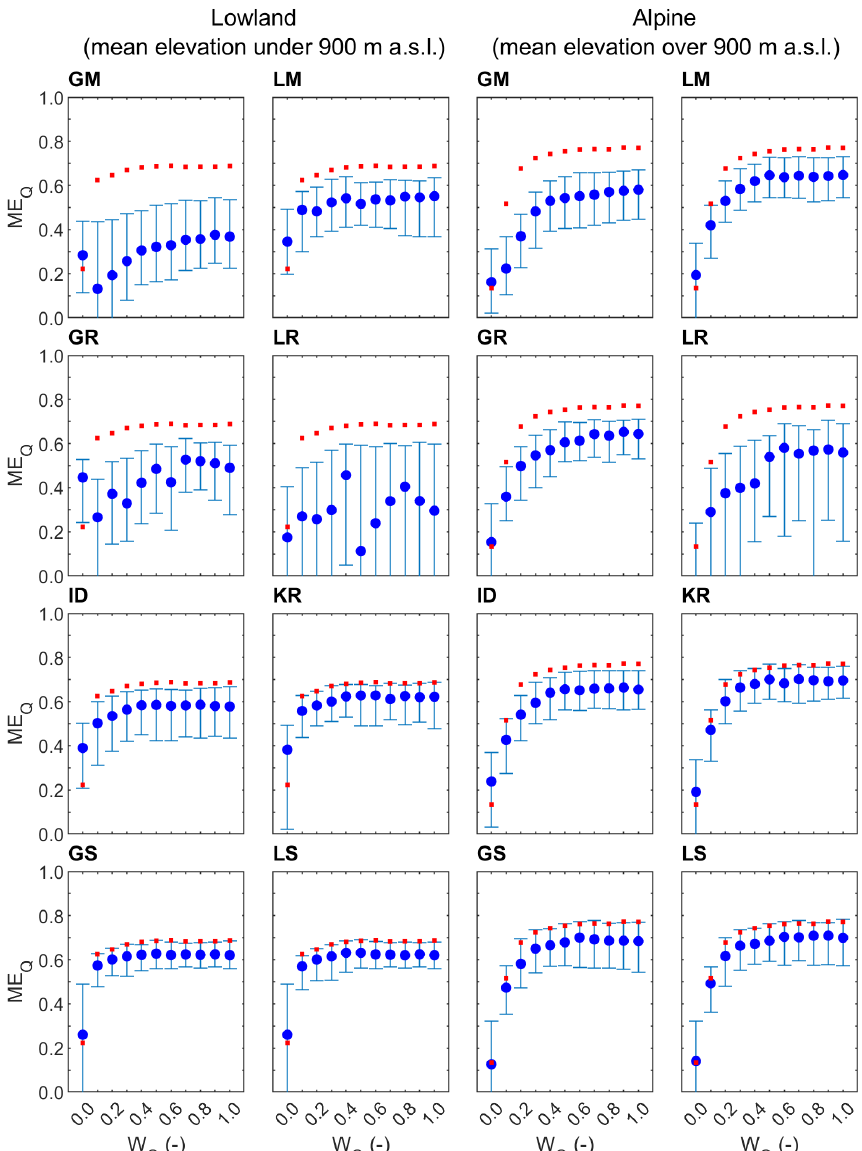
Figure 3. Same as Fig. 2 but for the validation period